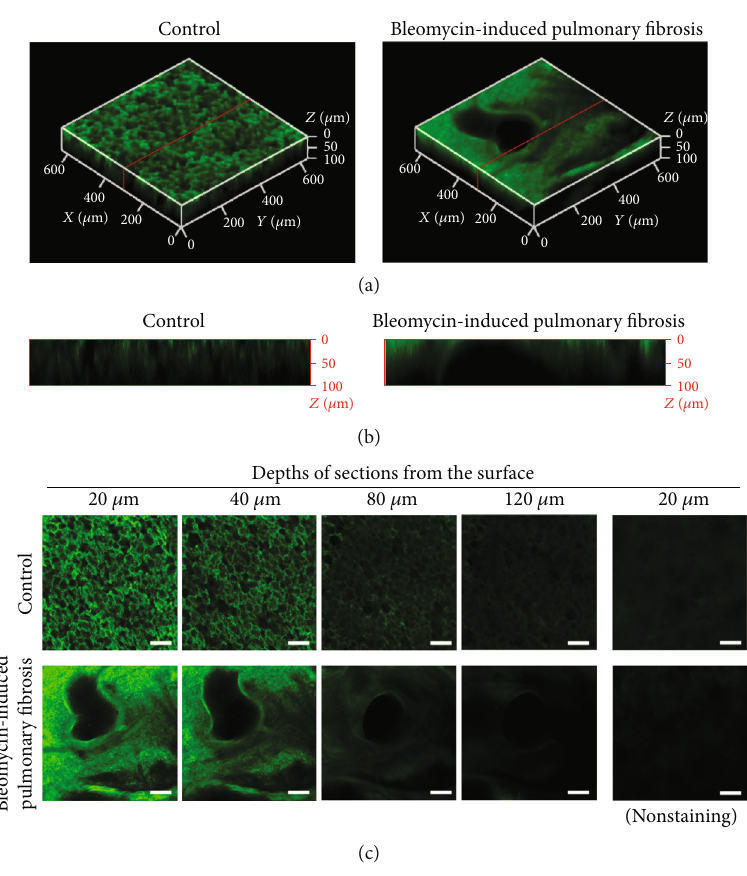
Figure 5: Three-dimensional images of collagen I stained using immuno fl uorescence in fi brotic lungs after Clear T2 tissue-clearing treatment. (a) Three-dimensional images reconstructed from single-plane images. Each 5 μ m stack is 20 – 120 μ m below the lung surface. (b) The image of cross-sections indicated by the red lines in (a). (c) Single-plane images at the indicated depth ( μ m) from the lung surface. Green fl uorescence indicates the localization of collagen I. The scale bar is 100 μ